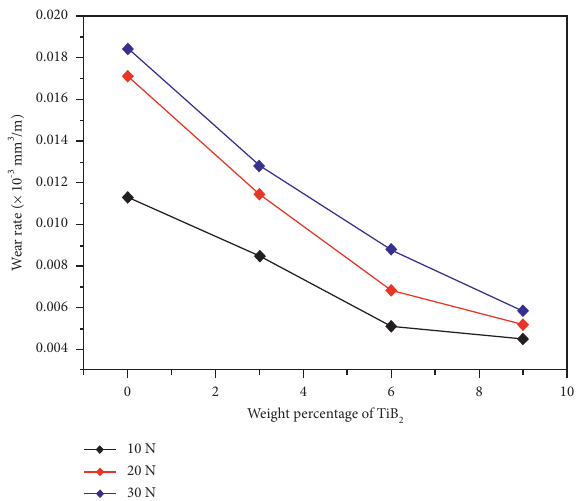
Figure 10: Wear rate with varying applied load for AA6082 and AA6082/TiB